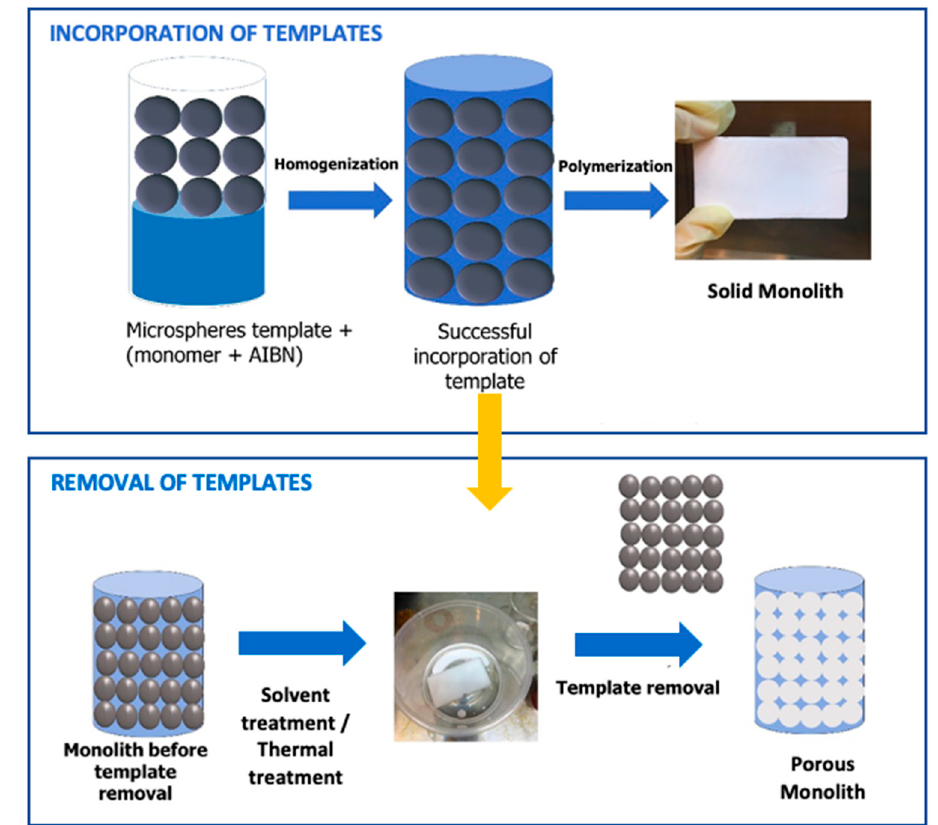
Figure 1. Schematic diagram of the preparation of porous monoliths using polystyrene microsphere particles as a pore-directing template. Part I: incorporation of the template into the monolith monomers. Part II: removal of the template via solvent treatment to produce a porous monolith.